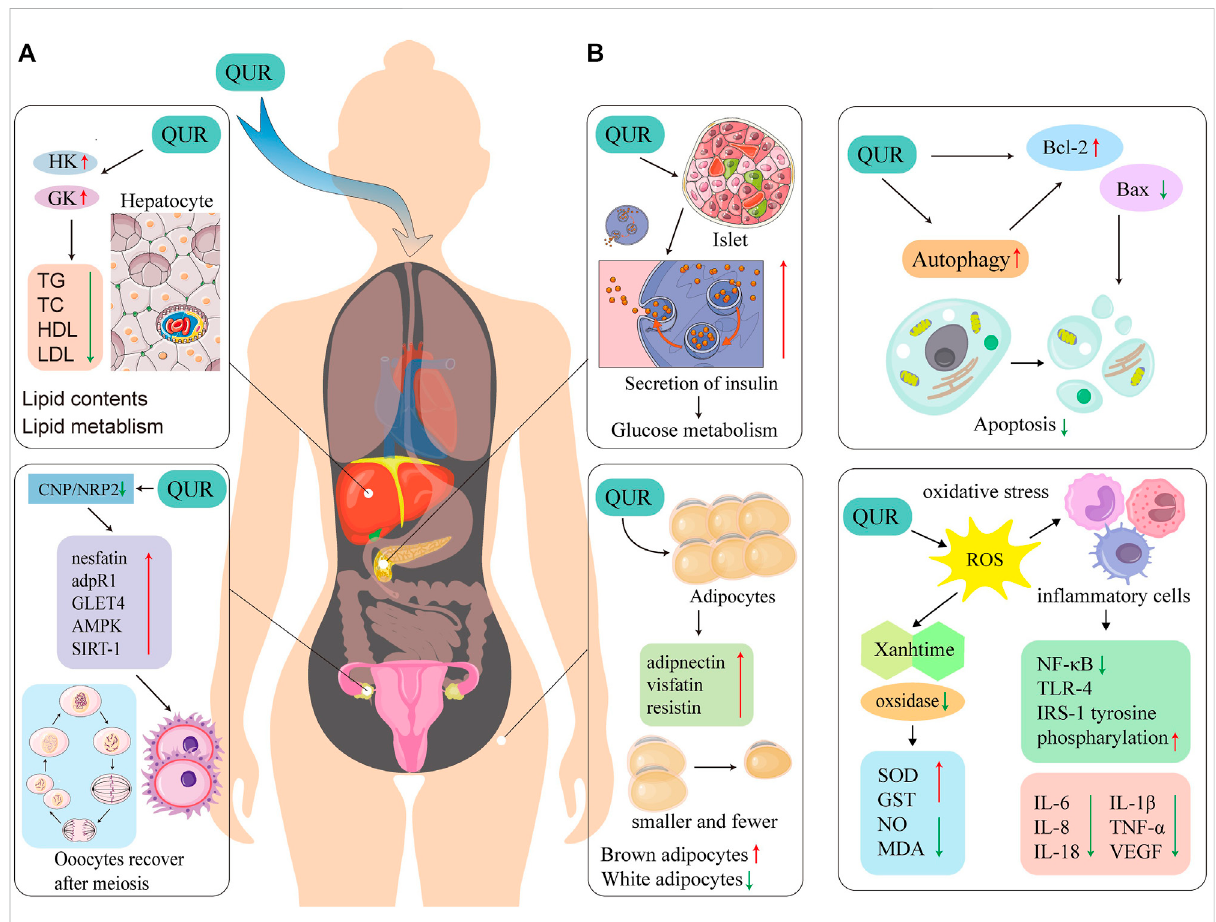
FIGURE 3 Proposed possible mechanisms of QUR treatment on PCOS. (A) . The possible mechanism of QUR ’ s role to treat PCOS in related organs. QUR can act on the pancreas to improve IR, and can act on the liver to increase HK and GK. QUR can promote the expression of nesfatin, adpR1, GLET4, AMPKandSIRT-1intheovaryunderthecombinedactionofCNP/NRP2,therebymakingtheoocyteCellsrepairrapidlyaftermeiosis.QURcanacton adipose tissue to increase the secretion of adiponectin, visfatin and resistin. (B) . QUR can inhibit cell apoptosis and improves oxidative stress. QUR can increase the expression of Bcl-2 in thetargetorgan, decrease the expression of Bax, to inhibit cell apoptosis. QURcan inhibitthe secretion of pro-in fl ammatory factors by in fl ammatory cells, promote the secretion of anti-in fl ammatory factors by in fl ammatory cells, making IL-6, IL-8, IL- 18, IL-1 β , TNF- α and VEGF expression decrease through NF- κ B, TLR-4, IRS-1 tyrosine and phosphorylation. QUR can inhibit oxidative stress and reduce xanthine-related oxidase, thereby increasing SOD, GST, NO, and MDA. QUR, quercetin; PCOS, polycystic ovary syndrome; IL-6, interleukin- 6; IL-8, interleukin-8; IL-18, interleukin-18; IL-1 β , interleukin-1 β ; TNF- α , tumor necrosis factor- α ; VEGF, vascular endothelial growth factor; NF- κ B, nuclear factor kappa-B; TLR-4, toll-like receptor 4; IRS-1, insulin receptor substrate-1; SOD, superoxide dismutase; GST, glutathione S-transferase; MDA,malondialdehyde; Bcl-2, B-celllymphoma-2;Bax,Blc-2 associated Xprotein; adpR1, adipoR1;GLET4, glucose transporters;AMPK,